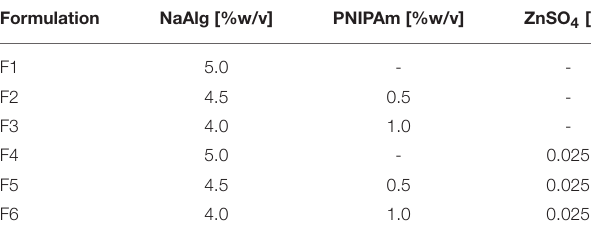
TABLE 2 | Sodium alginate-based bioink